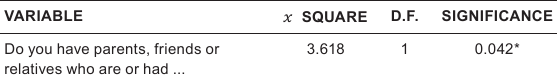
table 12 Chi-square-based measures of association between I don’t mind being committed to meet a regular payroll if it means that I can have a chance at greater